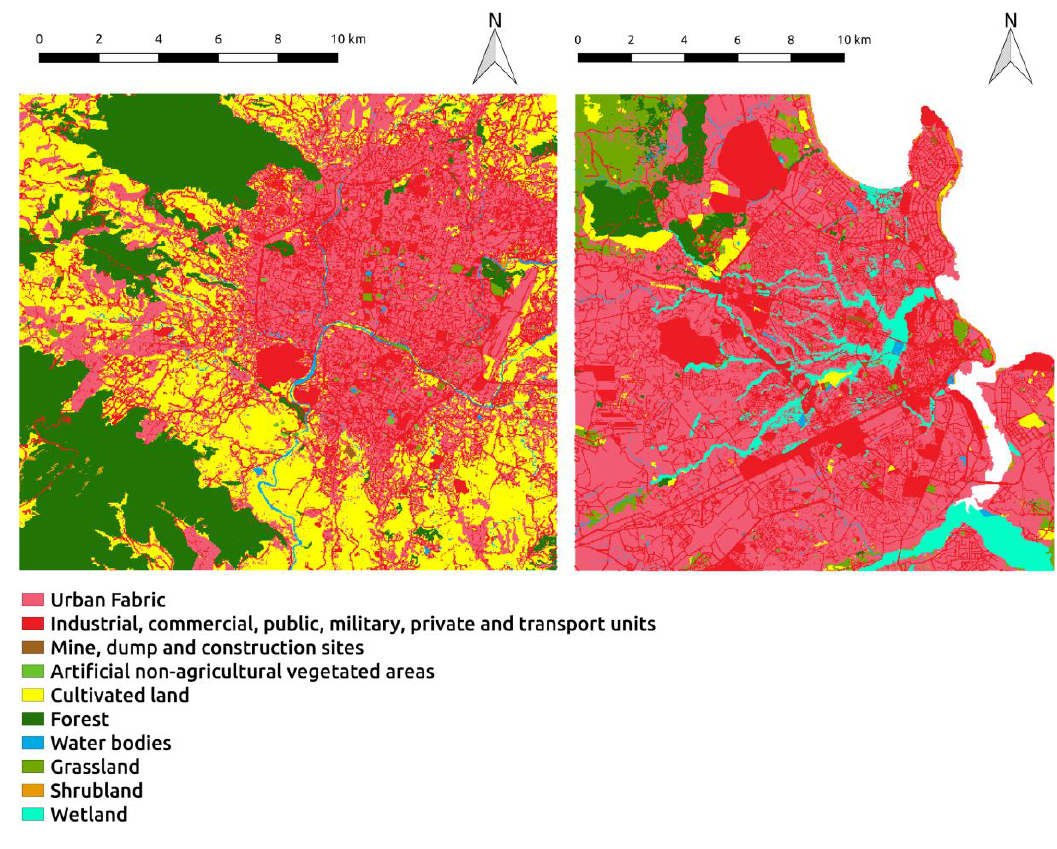
Figure 8. Enhanced GL30 for Kathmandu ( left ) and Dar es Salaam ( right ) study areas. Table 9. Distribution of urban LULC classes in the enhanced GL30 for Kathmandu and Dar es Salaam study areas.